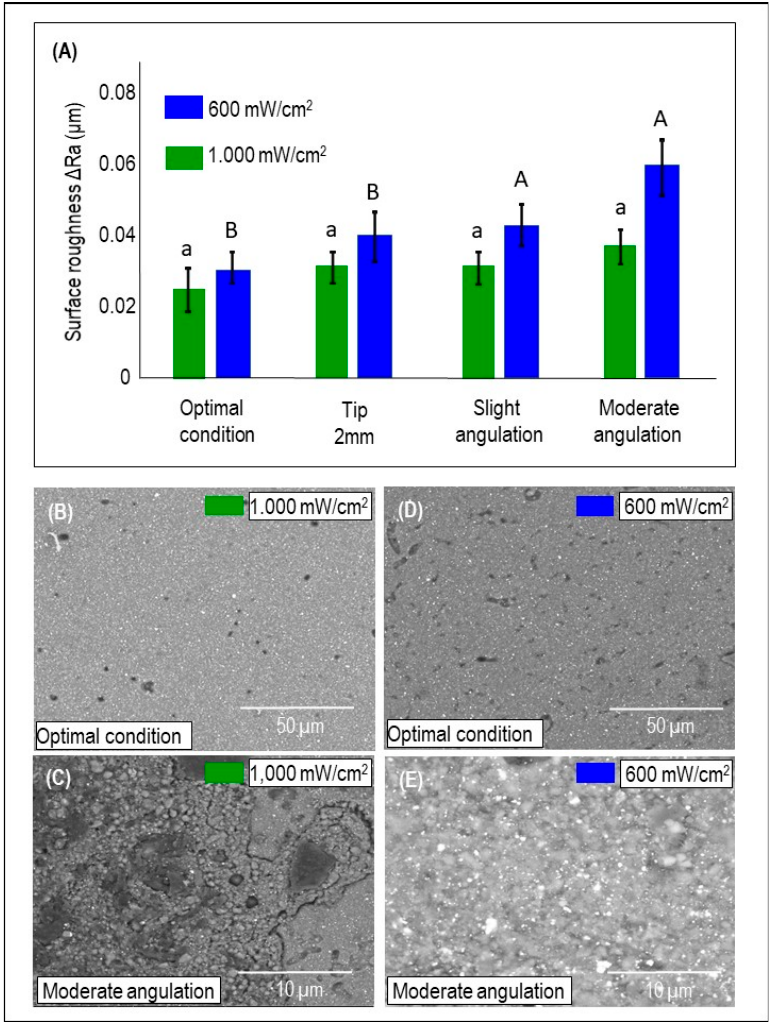
Figure 6. The topography changes of the bulk-fill (BF) composites cured in different conditions. ( A ) The mean and standard deviation of ∆ Ra values considering the underperformed light curing conditions and the two-radiance emittance output (mean ± sd; n = 6). Capital letters compare LCU 600 , while lower case letters compare LCU 1000 . Dissimilar letters are significantly different from each other ( p < 0.05). ( B – E ) Representative SEM images of the BF composite surface under control and moderate angulation following the output of 1000 mW/cm 2 ( B , C ) and LCU600 ( D , E